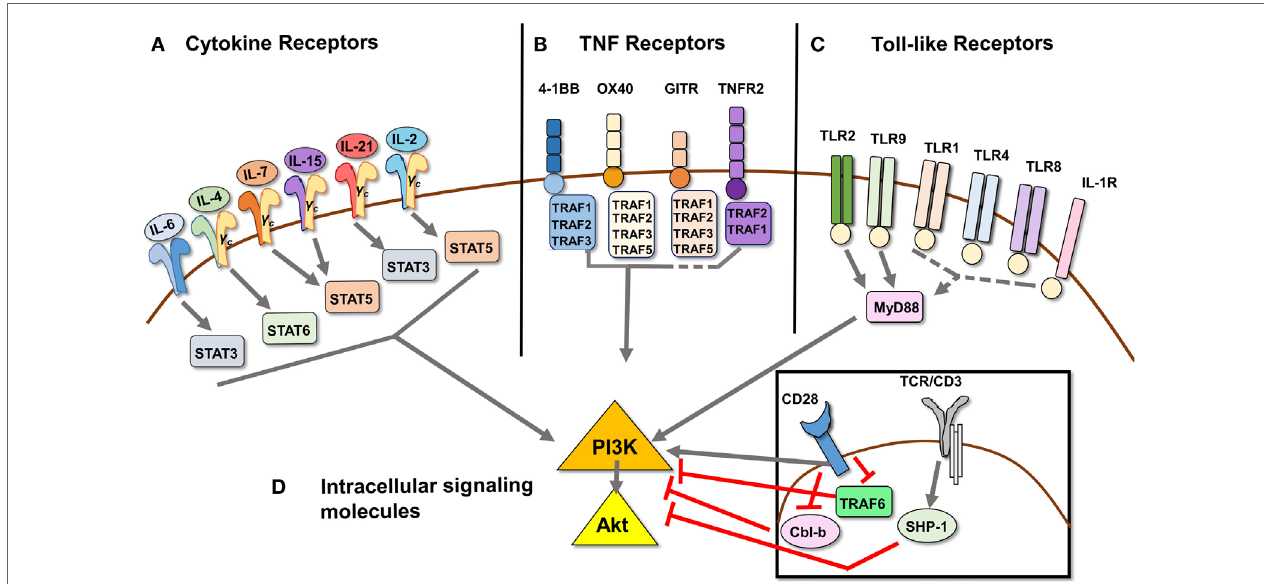
FiGURe 1 | Signal transduction pathways that mediate Treg resistance converge on the Pi3K/Akt pathway . (A) Cytokines IL-6, IL-4, IL-7, IL-15, IL-21, IL-2, and TNF α [ligand for TNFR2, see (B) as part of the TNFR superfamily] have been shown to induce Tcon cells to resist Treg suppression. The respective STAT molecule through which each predominantly signals is depicted. (B) Signaling through TNF receptors 4-1BB, OX40, GITR, and TNFR2 can induce Tcon cell resistance to Treg suppression, as they provide costimulatory signals similar to CD28 ligation. 4-1BB, OX40, and TNFR2 signaling has been shown to induce PI3K/ Akt activation via TRAF adaptor proteins, while GITR ligation has not been directly demonstrated to activate the PI3K/Akt pathway. (C) Toll-like receptors 1, 2, 4, 8, and 9, as well as IL-1R, also a member of the TLR family, have been shown to induce Treg resistance. Of these, only signaling through TLR2 and TLR9 has been shown to activate the PI3K/Akt pathway via recruitment of adaptor protein MyD88, which in turn recruits and activates PI3K via its Toll/interleukin-1 receptor domain. (D) Intracellular signaling molecules Cbl-b and SHP-1 act as negative regulators downstream of TCR signaling, and genetic deficiency in either induces Treg resistance. Cbl-b enforces the requirement for CD28 costimulatory signaling by inhibiting the recruitment of PI3K to CD28. TRAF6 also negatively regulates activation of PI3K downstream of CD28 costimulation by an as yet undefined mechanism. Dashed lines indicate proposed, but unconfirmed, links between receptors and/or signaling molecules and the PI3K/Akt